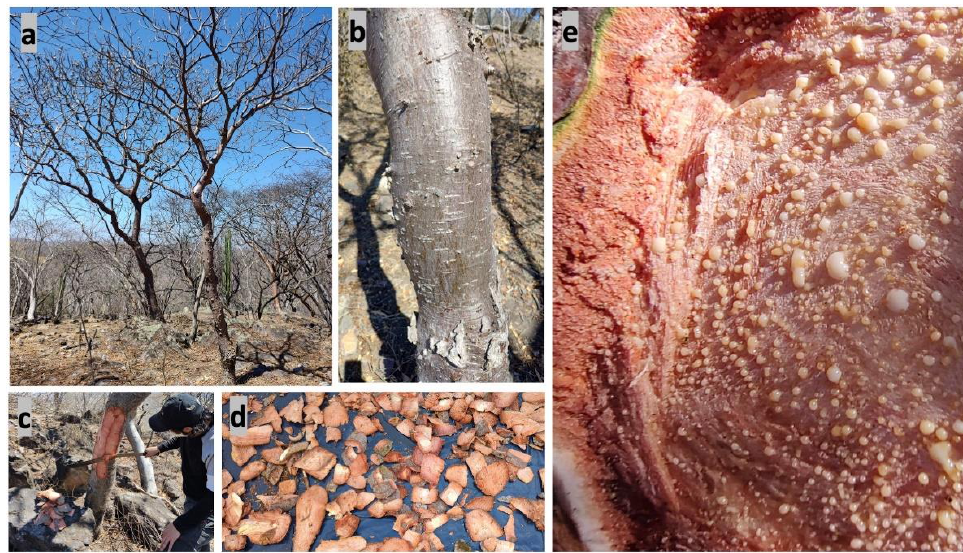
Figure 1. ( a ) A. adstringens trees in the dry season; ( b ) stem bark of tree showing smooth outer bark with lenticels; ( c ) traditional debarking; ( d ) traditionally dried stem bark, and ( e ) resin secretion from the stem bark induced by mechanical damage. Pictures taken by J.L. Díaz-Núñez in “ Los Sauces ” (Tepalcingo, Morelos, Mexico), February 2022.